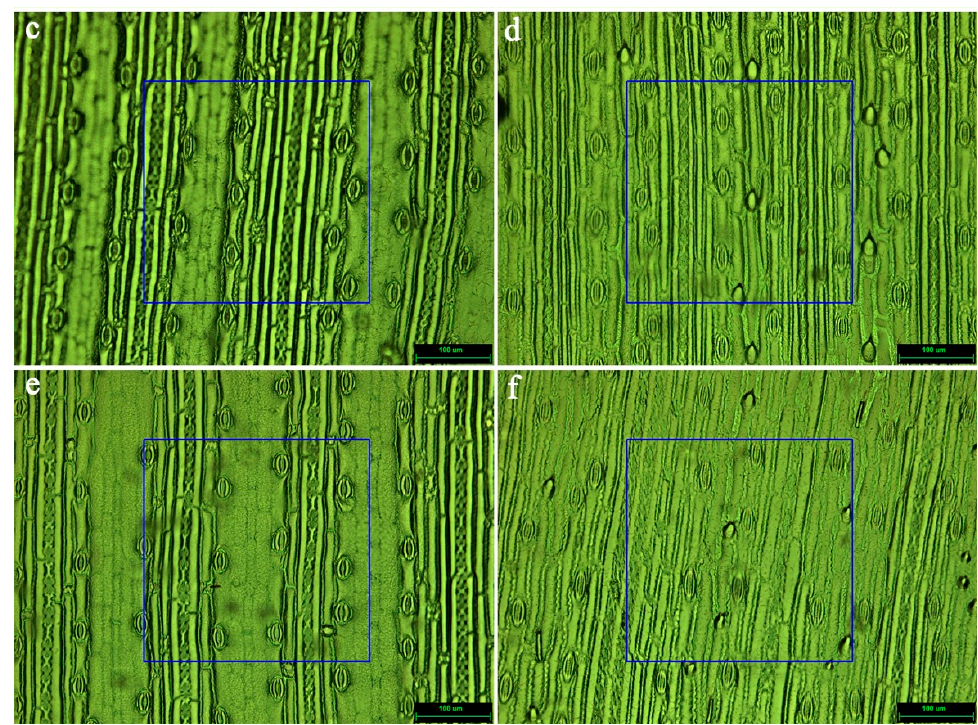
Figure 3. Stomatal impressions for the Kanlow genotype of Panicum virgatum at DAP 90 from the ( a , c , e ) adaxial and ( b , d , f ) abaxial surfaces. The images show different treatments—( a , b ) control, ( c , d ) 50 mM and ( e , f ) 100 mM of NaCl. The data within the blue squares represent an area of 0.09 mm 2 . Table 8. The stomatal density and number of salt glands on the adaxial and abaxial leaf surfaces of Panicum virgatum (Alamo, Kanlow and Traiblazer) subjected to the control, 50, 100, 200 and 300 mM NaCl treatments at 180